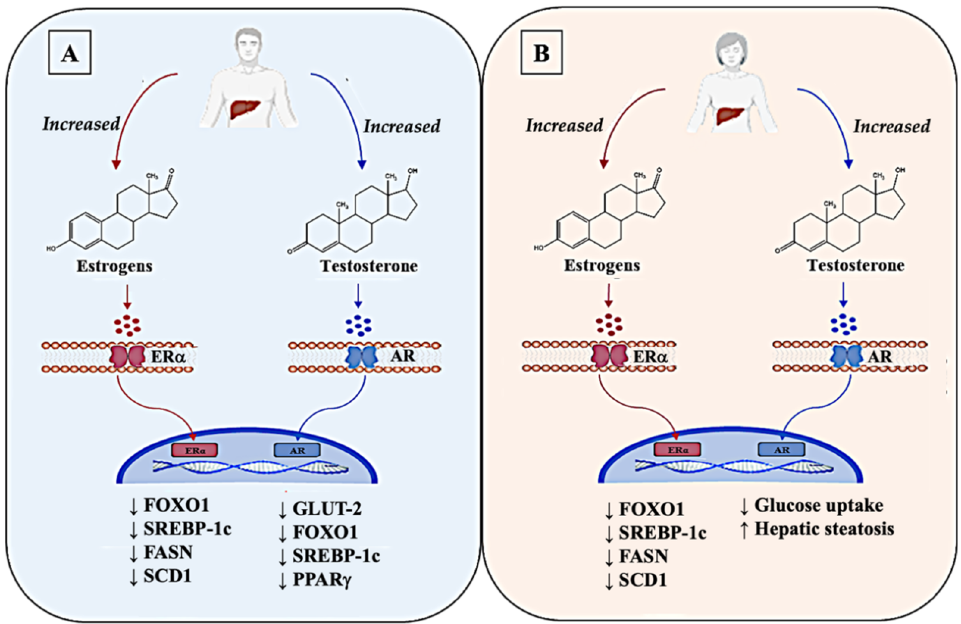
Figure 2. Dimorphism of the sex hormones estrogens and testosterone in the liver of the two sexes. Estrogens display a similar role in both sexes, interacting with their receptors (ER α ) in plasma membrane of liver cells, which, once activated, migrate in the nucleus and bind to estrogen-responsive element (ERE) on their target genes. Estrogens suppress hepatic glucose production (HGP) by inhibiting the expression of FOXO1. Estrogens also impair the hepatic de novo lipogenesis (DNL) by reducing the expression of genes such as SREBP-1C, FASN, and SCD1, and promote fatty-acid oxidation (FAO). Overall, in physiologic conditions, estrogens play a significant role in the modulation of glucose equilibrium in the liver of both sexes ( A , B ). In contrast, androgens, especially testosterone, show different functions in the liver of the two sexes through the interaction with their membrane receptors AR. In male livers, an increase in testosterone levels has beneficial effects in reducing glucose uptake, by inhibiting the transcription of GLUT-2. It has an important action also in the reduction in DNL in male livers, acting in the suppression of the transcription of SREBP-1C and PPAR γ and in the inhibition of HGP through FOXO1 ( A ). Differently, in female livers, altered levels of testosterone promote an increase in hepatic steatosis by impairing hepatic glucose metabolism, thus predisposing females to insulin resistance ( B ). Up arrows ( ↑ ) and down arrows ( ↓ ) indicate, respectively, enhanced and reduced expression (in the case of a gene), production (in the case of mediators), and occurrence (in the case of the relative pathological event).